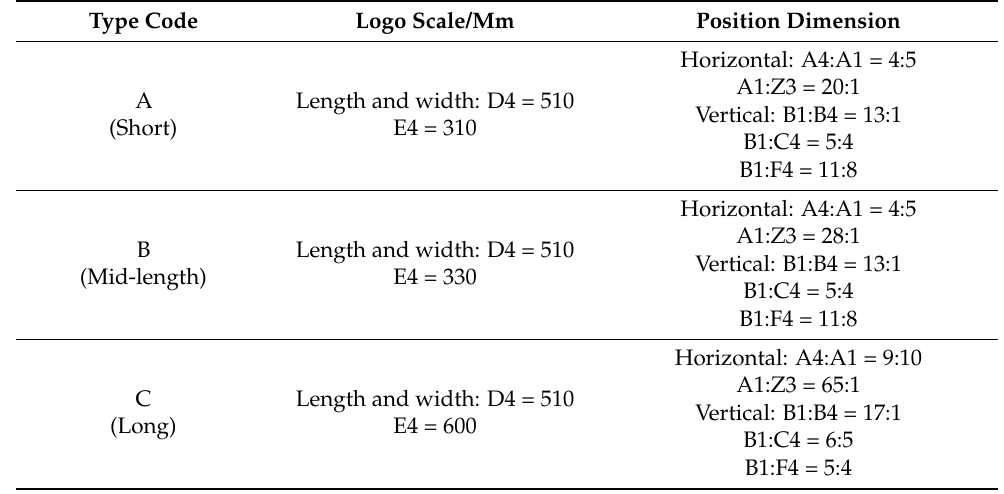
Table 4. The modelling scale specification of the logo and machine tool